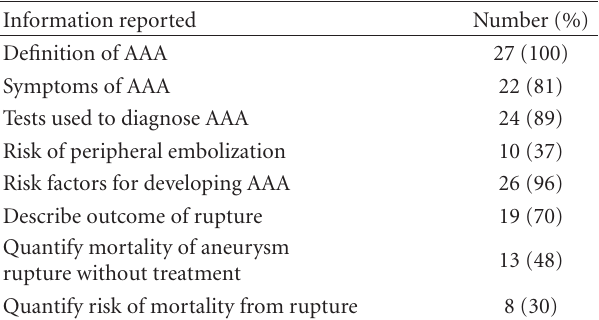
Table 1: Descriptive information.